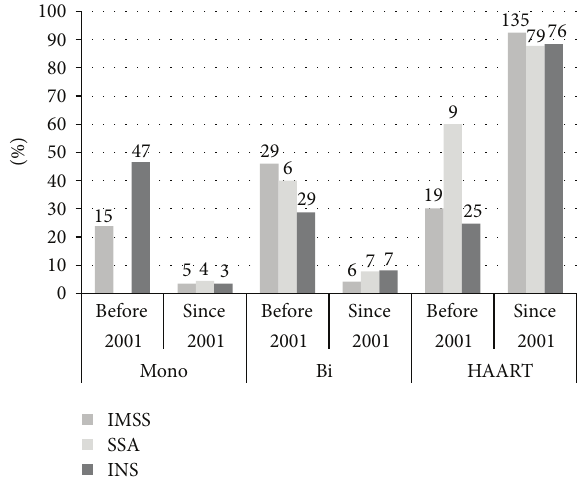
Figure 3: Distribution of patients by health subsystem and the type of initial ARVT. ∗ Percentages were calculated with respect to the number of patients initiating therapy by period in each facility. IMSS information was available from 1993, SSA from 1999, and INS from 1990. The number over each bar is the total number of patients by category.